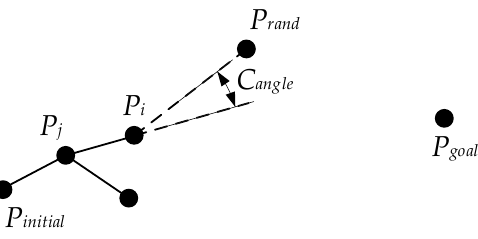
Figure 7. Calculation of the included